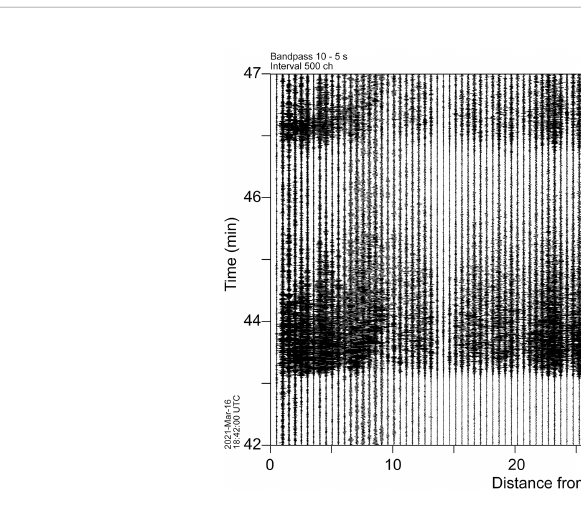
FIGURE 4 | Time – distance pro fi le of phase data for a teleseismic event recorded by the DAS system. The phase data of each channel were band-passed from 10 to 5 s to increase the S/N ratio. The horizontal axis is distance from the coast, and the vertical axis shows time. Each trace is plotted using the same amplitude scale. There are 10,000 channels in the DAS measurement, and only 100 channels are plotted at an interval of 100 channels. An earthquake with a magnitude of 6.6 occurred under Kamchatka Peninsula, Russia on March 16, 2021, and the epicentral distance from the cable system was approximately 2,300 km. Amplitudes of seismic signals had variations depending on the channel